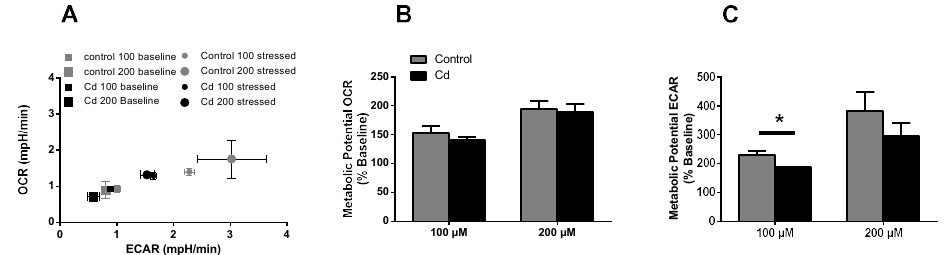
Figure 7. Energy phenotype assay (in vitro). ( A ) OCR vs ECAR of control and Cd-exposed coelomocytes. The term stressed refers to the state after Oligo/FCCP addition. ( B–C ) Metabolic ECAR and OCR potential of in vitro Cd exposed coelomocytes. *ANOVA on ranks and post-hoc Tukey test revealed significant differences at p ≤ 0.05.